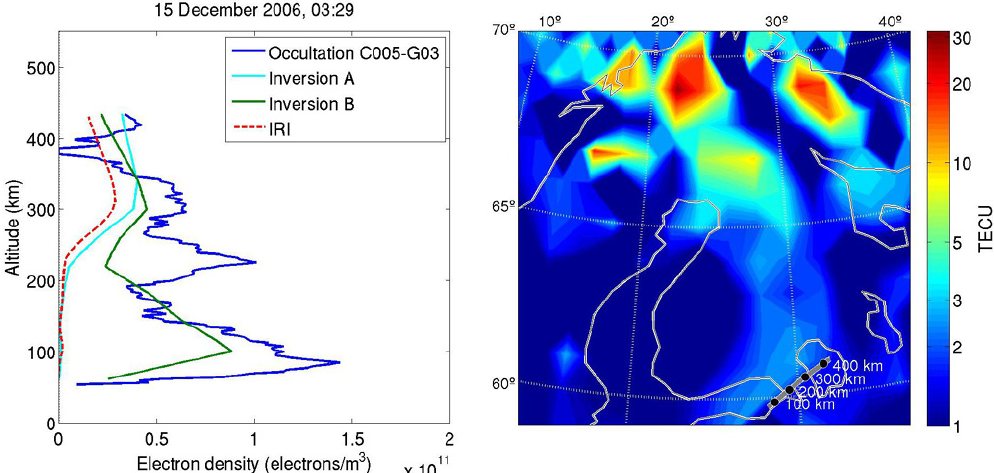
Fig. 10. Comparison between the inversion result and occultation measurement on 15 December, 03:29, between COSMIC satellite 5 and GPS satellite 3. Left: vertical electron density profiles, including also the IRI-model. Right: VTEC map from the inversion result, with the location of the occultation measurement included.